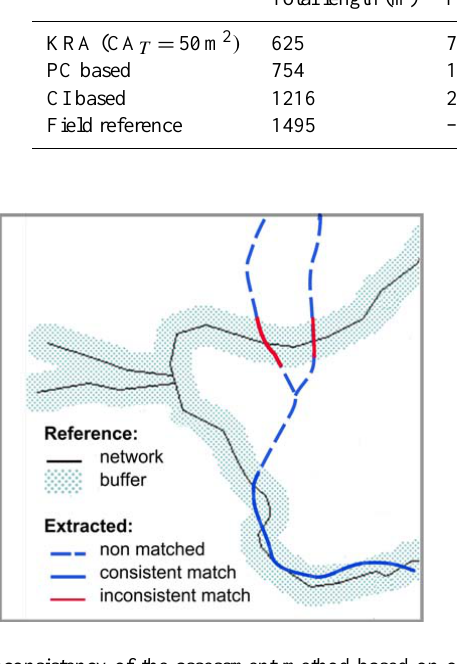
Figure 4. Inconsistency of the assessment-method based on overlap length. 2 Fig. 4. Inconsistency of the assessment-method based on overlap length.